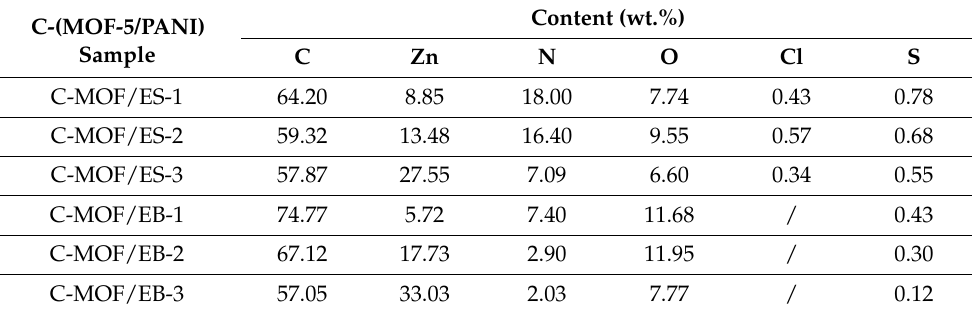
Table 2. The elemental composition of C-(MOF-5/PANI) samples determined from EDX